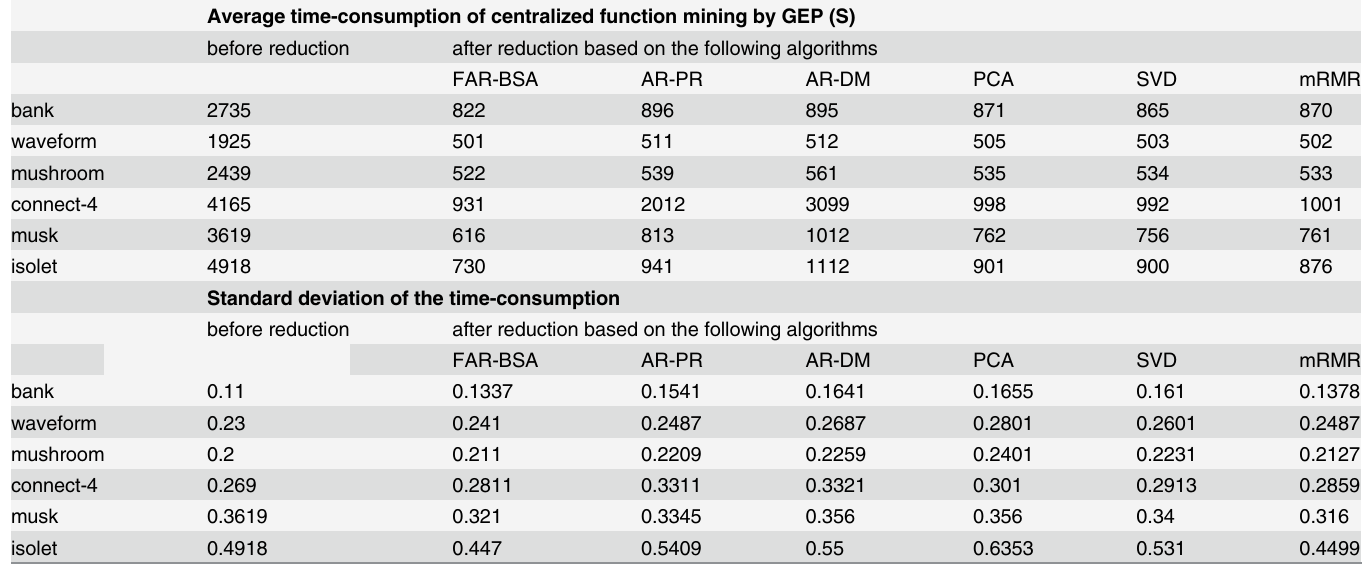
Table 4. Comparison of the average time-consumption and standard deviation of the time-consumption by centralized function mining for six data sets before and after reduction. Average time-consumption of centralized function mining by GEP